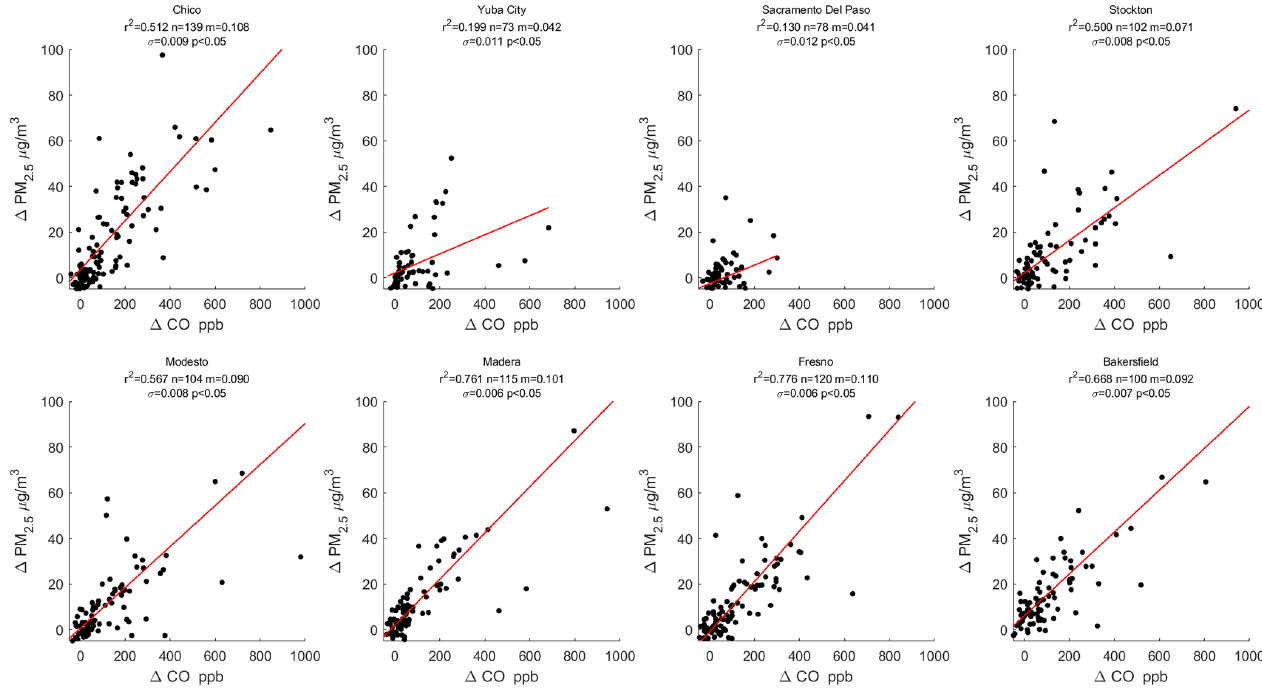
Figure B3. Scatter plot and linear regression for (cid:49) PM 2 . 5 vs. (cid:49) CO at each site. Enhancements are the differences in afternoon (10:00– 15:00PST) mean values between wildfire and background periods. The m is the slope or enhancement ratio, n is the number of data points in the regression, σ is the standard error for the linear regression, and p is the P value which represents the rejection of null hypothesis.